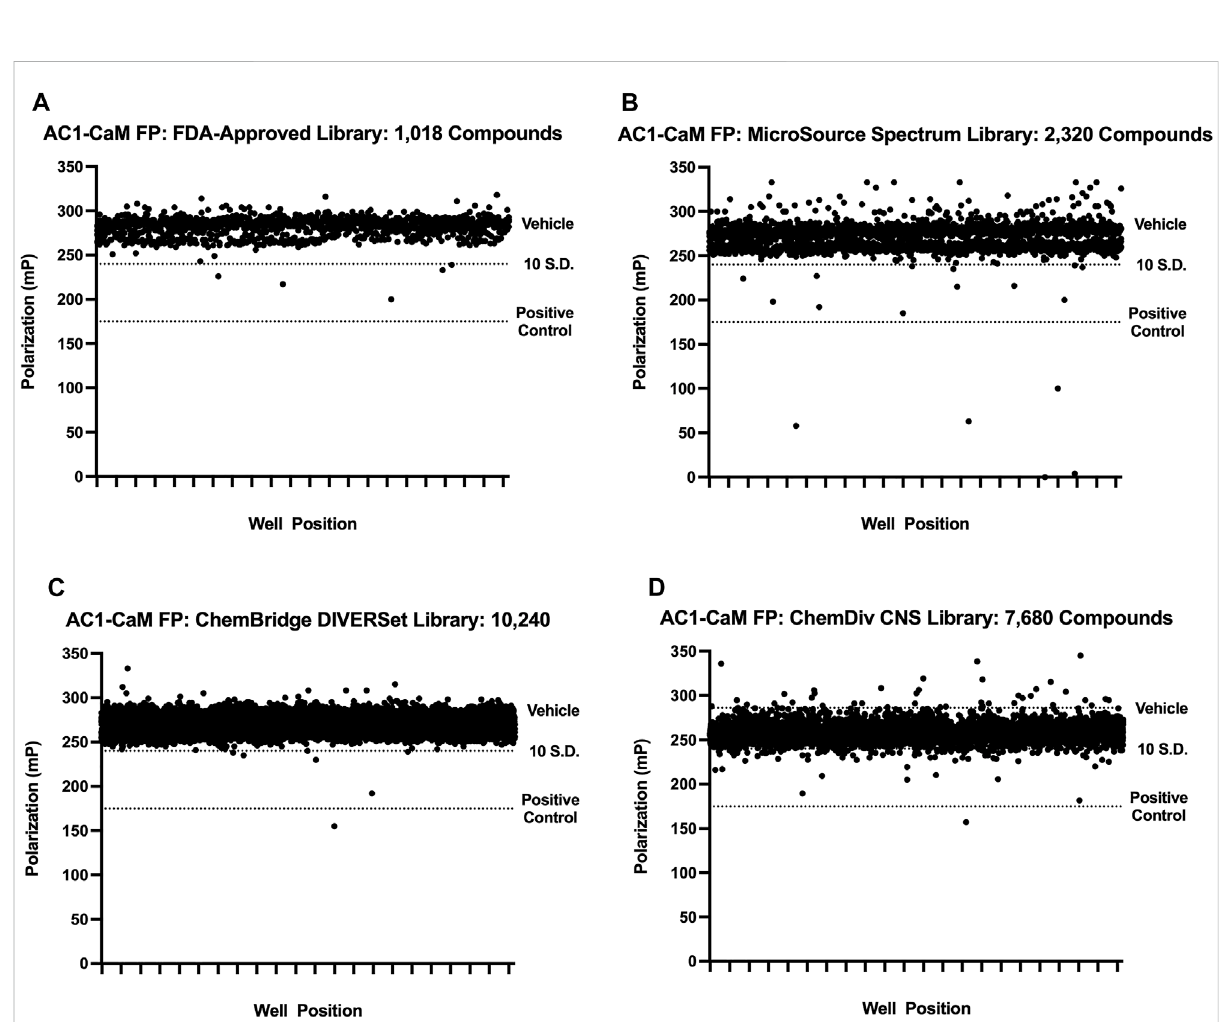
FIGURE 2 Pilot screen individuallibrary results. All pilot screen assays used concentrations of AC1 and CaMshown in Table 1. The dottedline representing the vehicle is beneath the cluster of compounds screened (black circles). 100 μ M CDZ is shown as the dotted line labeled as positive control. Polarization values correspond to well positions for plates within the library tested. (A) FDA-approved library, (B) MicroSource Spectrum (MMSP) library, (C) ChemBridge DIVERSet library, (D) ChemDiv CNS